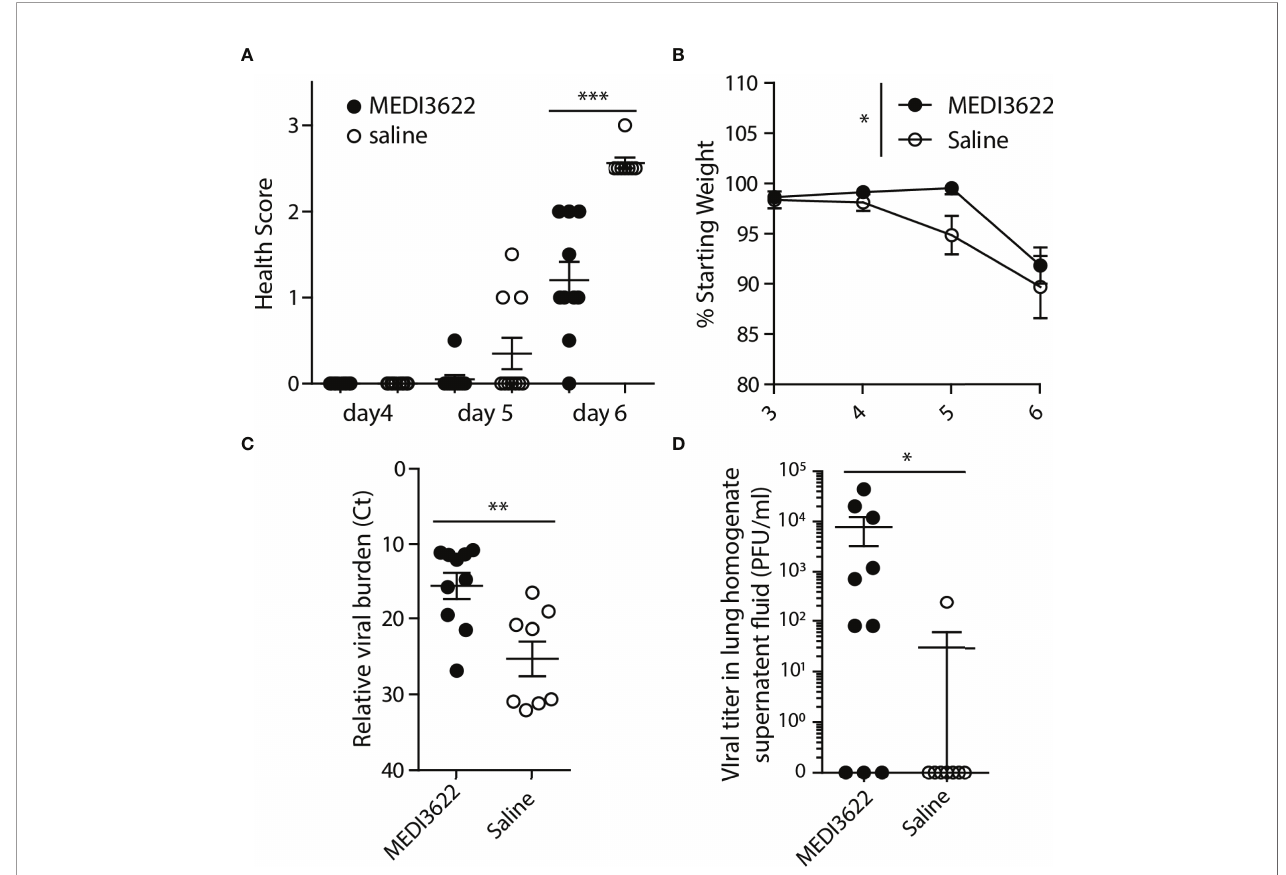
FIGURE 1 | Treatment of SARS-CoV-2 infected mice with MEDI3622 mAb ameliorates morbidity, but increases viral titers. (A) MEDI3622 mAb treated mice have diminished morbidity compared to saline-treated mice. (B) MEDI3622-treated mice lose signi fi cantly less weight than saline-treated controls (represented as the percentage of starting weight at time of infection for each mouse) (2-way ANOVA, *p<0.05). MEDI3622-treated mice have greater relative viral burdens than saline-treated mice as measured by (C) qPCR and (D) plaque assay Mann-Whitney test *p<0.05, **p<0.01, ***p<0.001. This experiment was performed similarly 2 independent times with 10 mice per